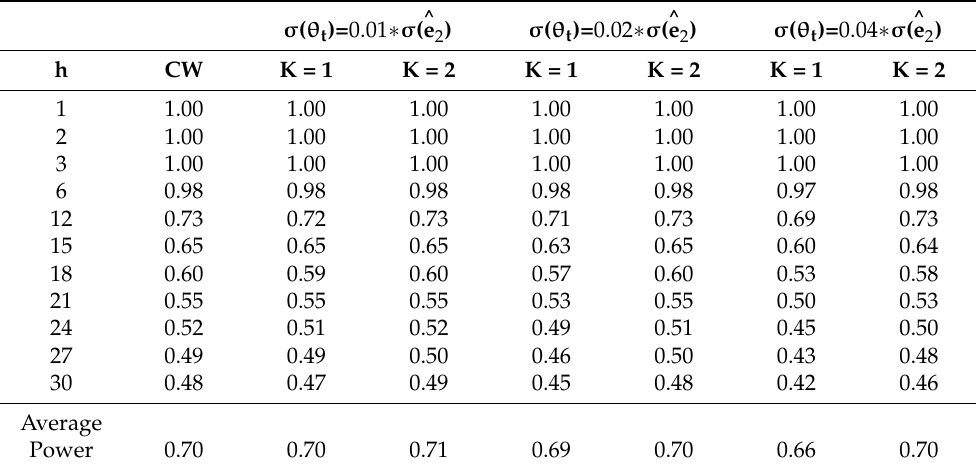
Table 12. Power comparisons between CW and WCW tests with nominal size of 10%, considering DGP3 and a small